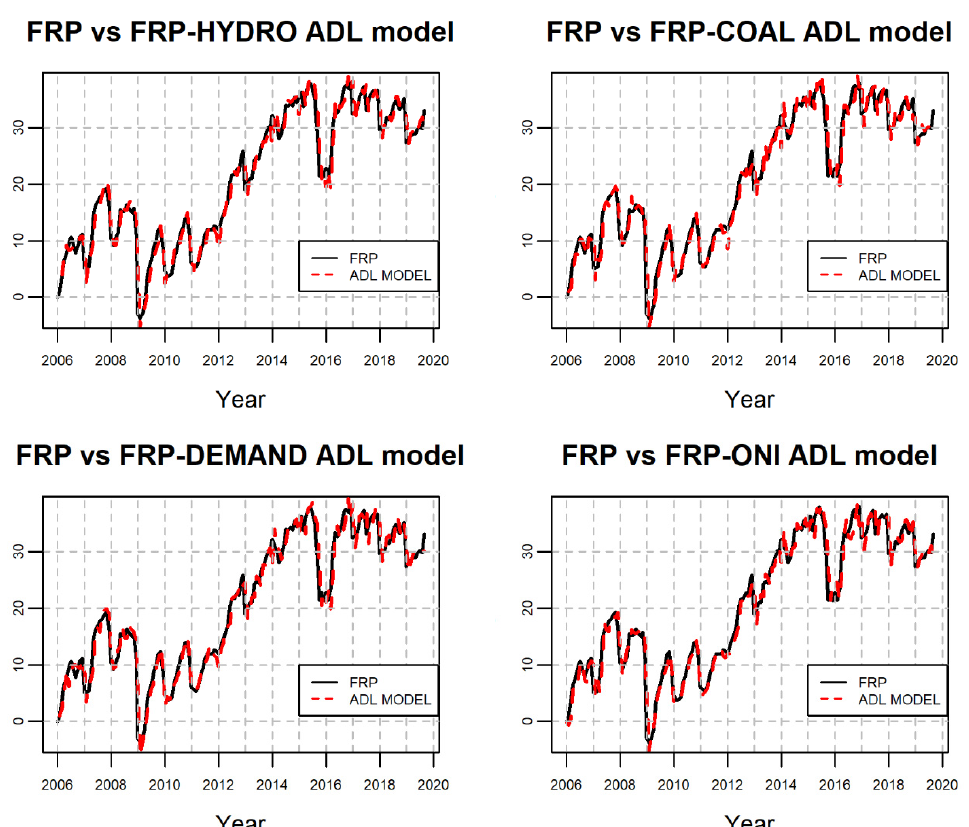
Figure 3. Estimated ADL models versus the original FRP series.